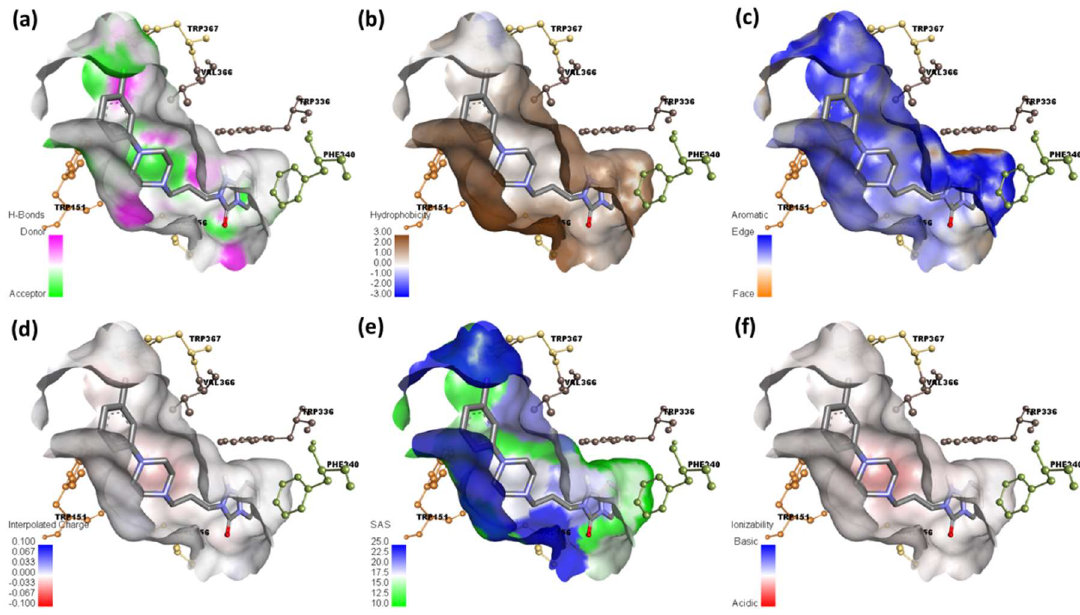
Figure 13. Molecular docking analysis. ( a ) hydrogen binding surface, ( b ) hydrophobic surface, ( c ) aromatic surface, ( d ) interpolated charge, ( e ) solvent accessible surface area, and ( f ) ionizability surface; between serotonin and TZD drug only .